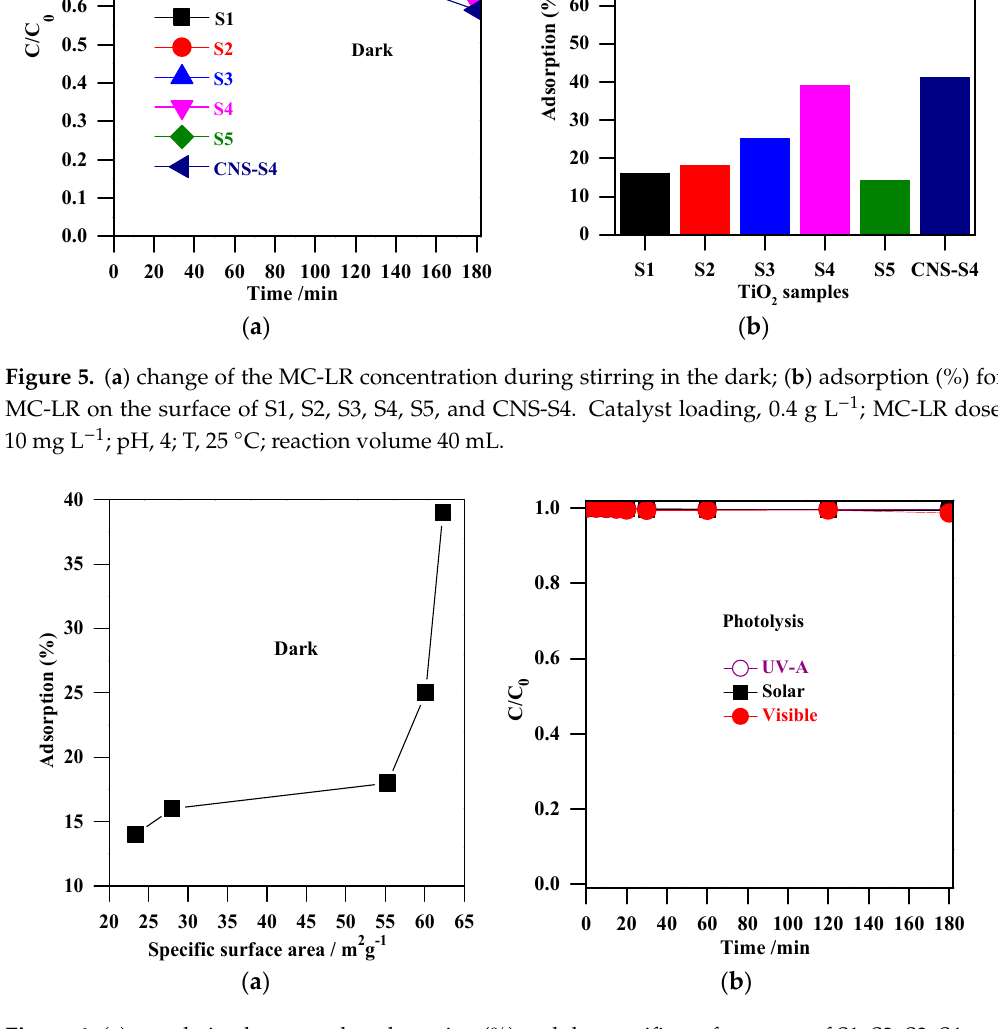
Figure 6. ( a ) correlation between the adsorption (%) and the specific surface areas of S1, S2, S3, S4 and S5 samples; ( b ) MC-LR photolysis by UV-A, solar and visible irradiation.